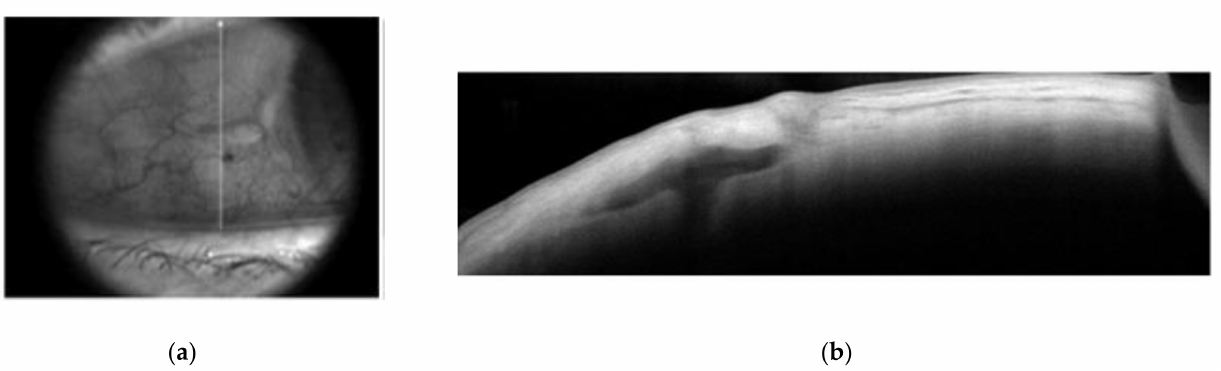
Figure 3. ( a ) Infrared image of the scleral flap in a patient implanted with the Carlevale IOL; ( b ) optical coherence tomography of the scleral flap showing the correct placement of the plug in the same